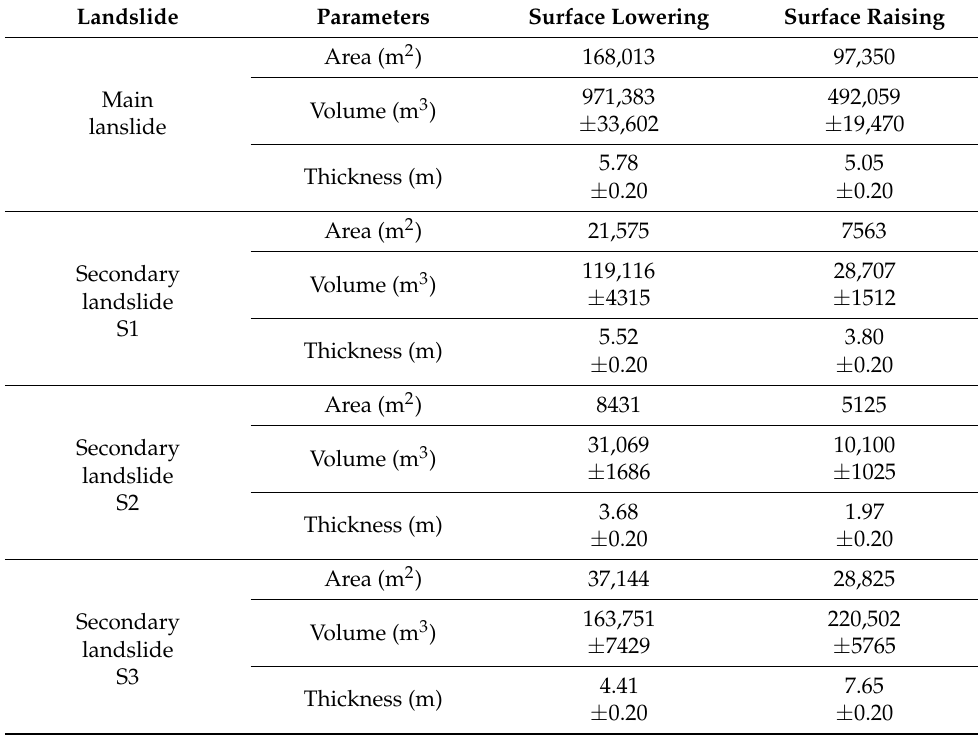
Table 2. Topographic changes in the landslide in terms of area, volume and thickness. Landslide